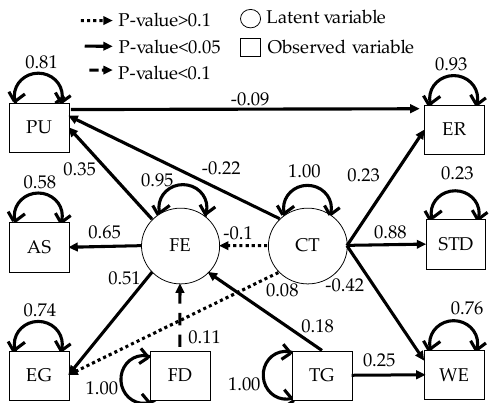
Figure 5. Covariance structure analysis result of the psychological model (PU: Pleasant emotion, AS: Arousal, EG: engagement, FE: flow experience, CT: complexity of the task, TG: target, FD: feedback, ER: human error, STD: subjective task difficulty, WE: work efficiency.).